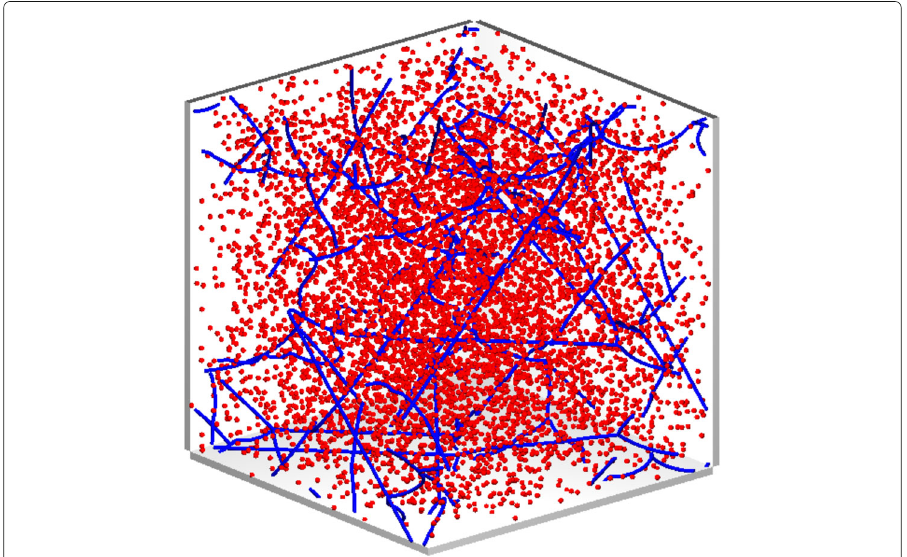
Fig. 1 Snapshot of a simulated system. The parameters were set to ρ p = 10 20 m − 3 and the image is taken at t = 10 − 9 s = 2.6 · 10 5 GM , where M = M edge = M